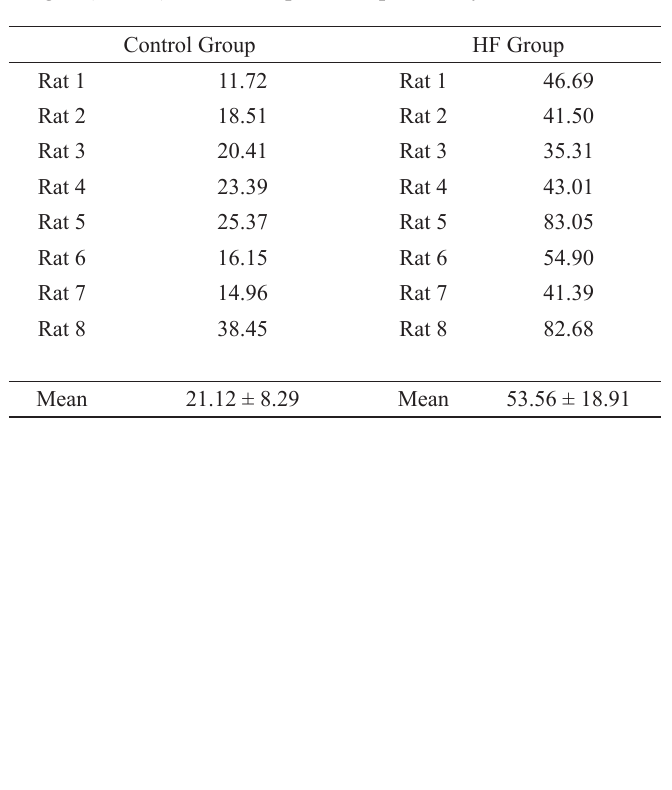
TABLE 1 - Data presented as means and standard deviation (SD). Results of individual liver regeneration index. Liver regeneration was assessed by proliferating cell nuclear antigen (PCNA) 24 hr after partial hepatectomy.